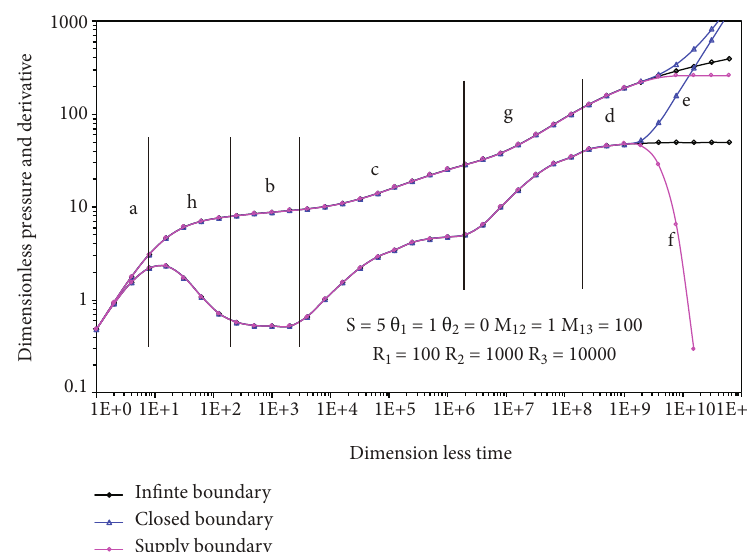
Figure 6: Typical pressure performance curve for a three-zone homogeneous radial composite reservoir with exponentially changing physical properties in the transition